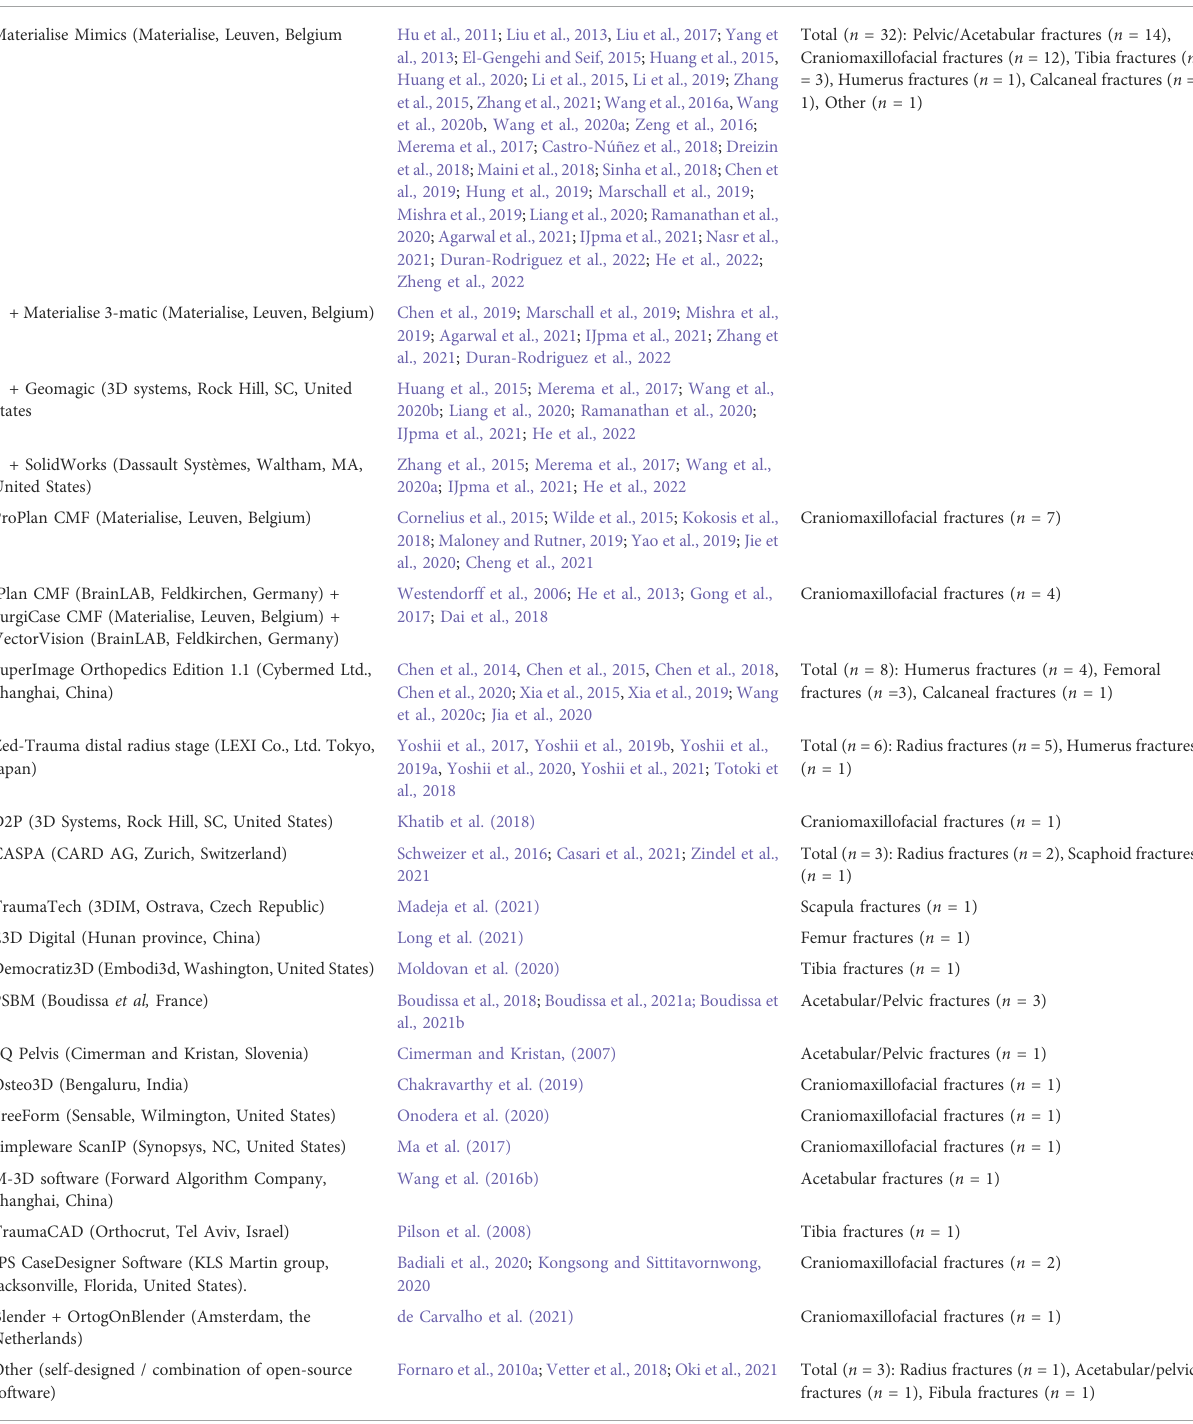
geometrical models, virtual bone fracture reduction and virtual bone fracture fi xation. The used implant for virtual fi xation is often designed using Materialise 3-matic (Materialise, Leuven,